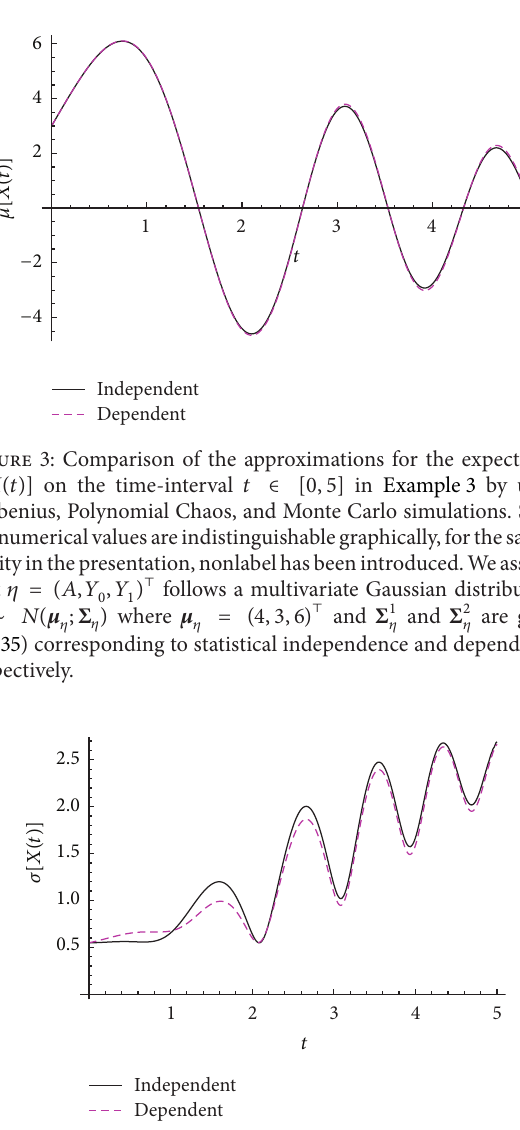
Figure 4: Comparison of the approximations for the standard deviation 𝜎[𝑋(𝑡)] on the time-interval 𝑡 ∈ [0, 5] in Example 3 by using Fr¨obenius, Polynomial Chaos, and Monte Carlo simulations. Since the numerical values are indistinguishable graphically, for the sake of clarity in the presentation, nonlabel has been introduced. We assume that 𝜂 = (𝐴, 𝑌 0 ,𝑌 1 ) ⊤ follows a multivariate Gaussian distribution: 𝜂 ∼ 𝑁( 𝜇 𝜂 ; Σ 𝜂 ) where 𝜇 𝜂 = (4, 3,6) ⊤ and Σ 1 𝜂 and Σ 2 𝜂 are given by (35) corresponding to statistical independence and dependence,